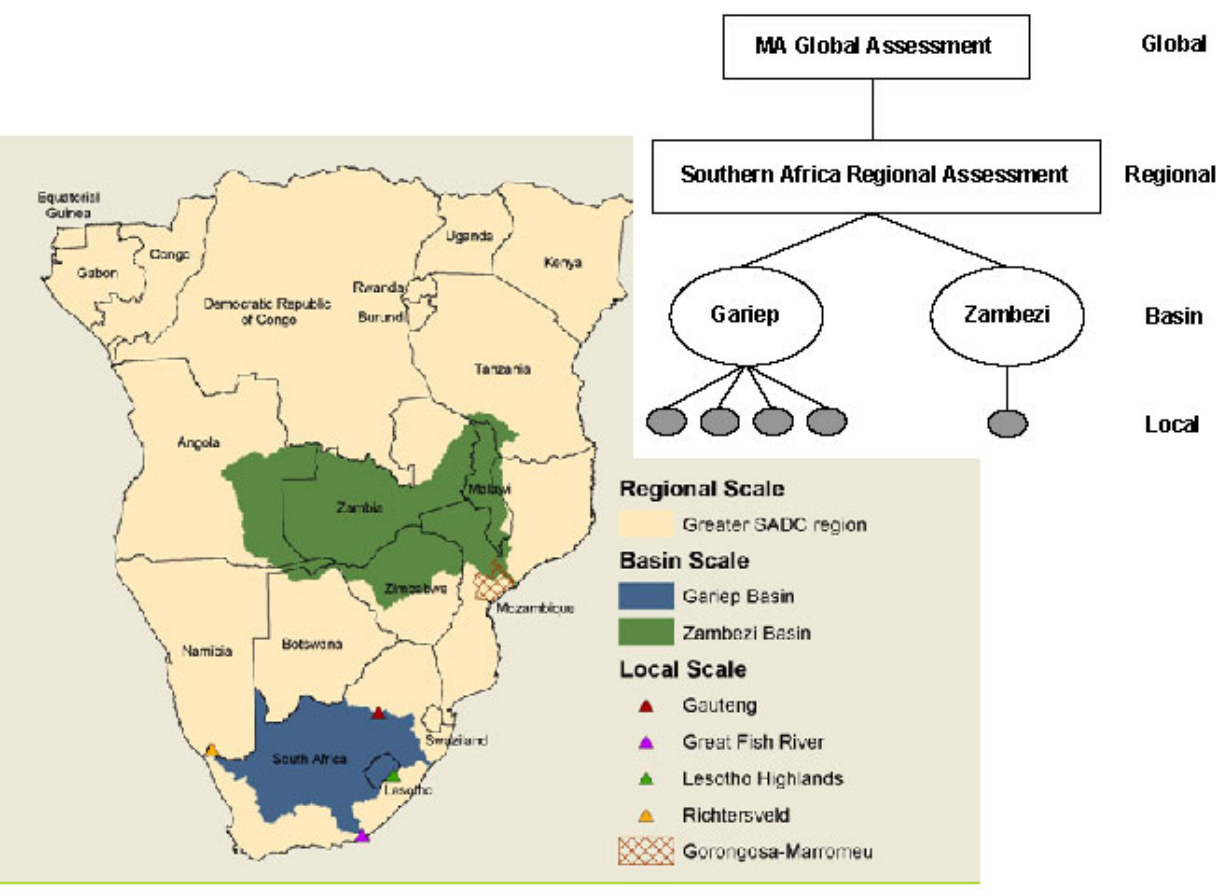
Fig. 2 . The Southern Africa Millennium Ecosystem Assessment study area and its multiscale nested design. MA stands for Millennium Ecosystem Assessment, and SADC for Southern African Development